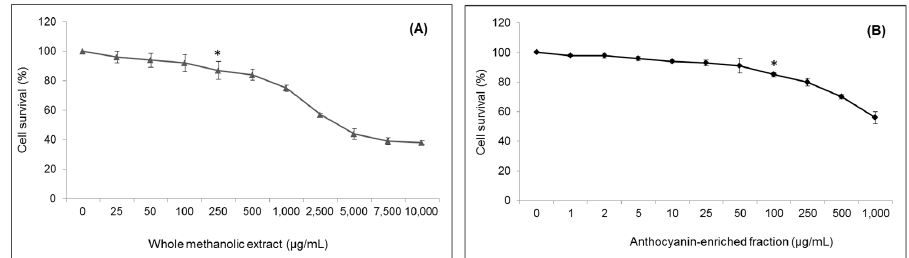
Figure 1. Viability of HepG2 cells after treatment with strawberry whole methanolic extract ( A ) and the anthocyanin-enriched fraction ( B ). Cells were treated with the indicated concentration of strawberry extracts for 24 h. Values are expressed as the mean ± SD of three independent experiments ( n = 3). The asterisk indicates the concentrations from which significant differences ( p < 0.05) were observed compared to the control.